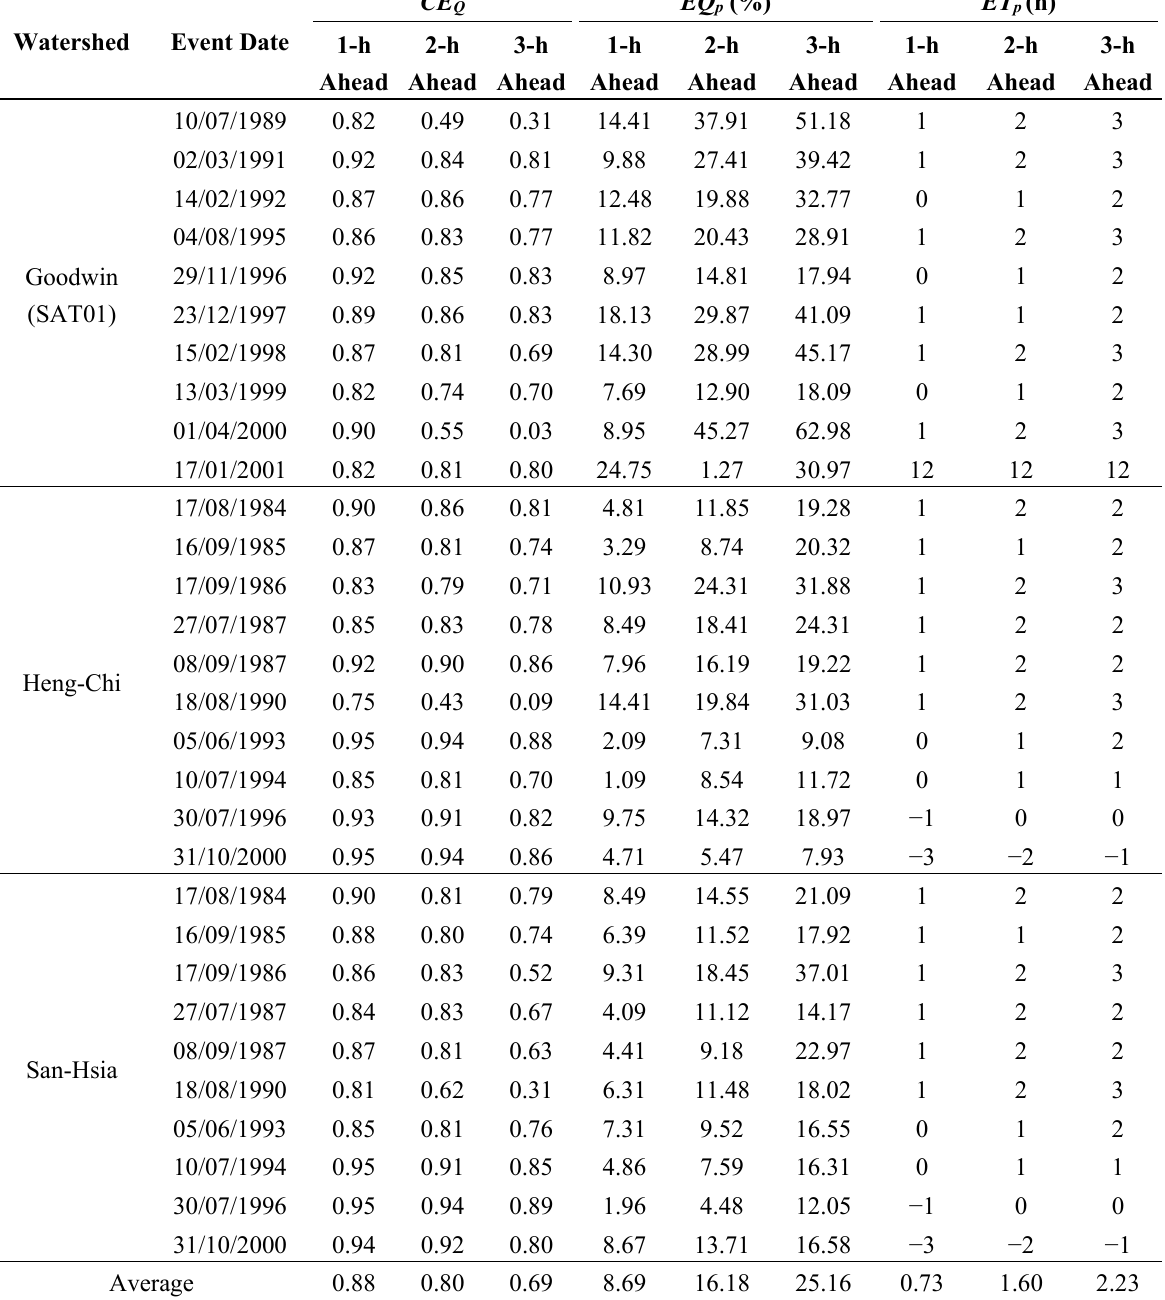
Table 5. Results of flow forecasting using forecast rainfall and without flow updating